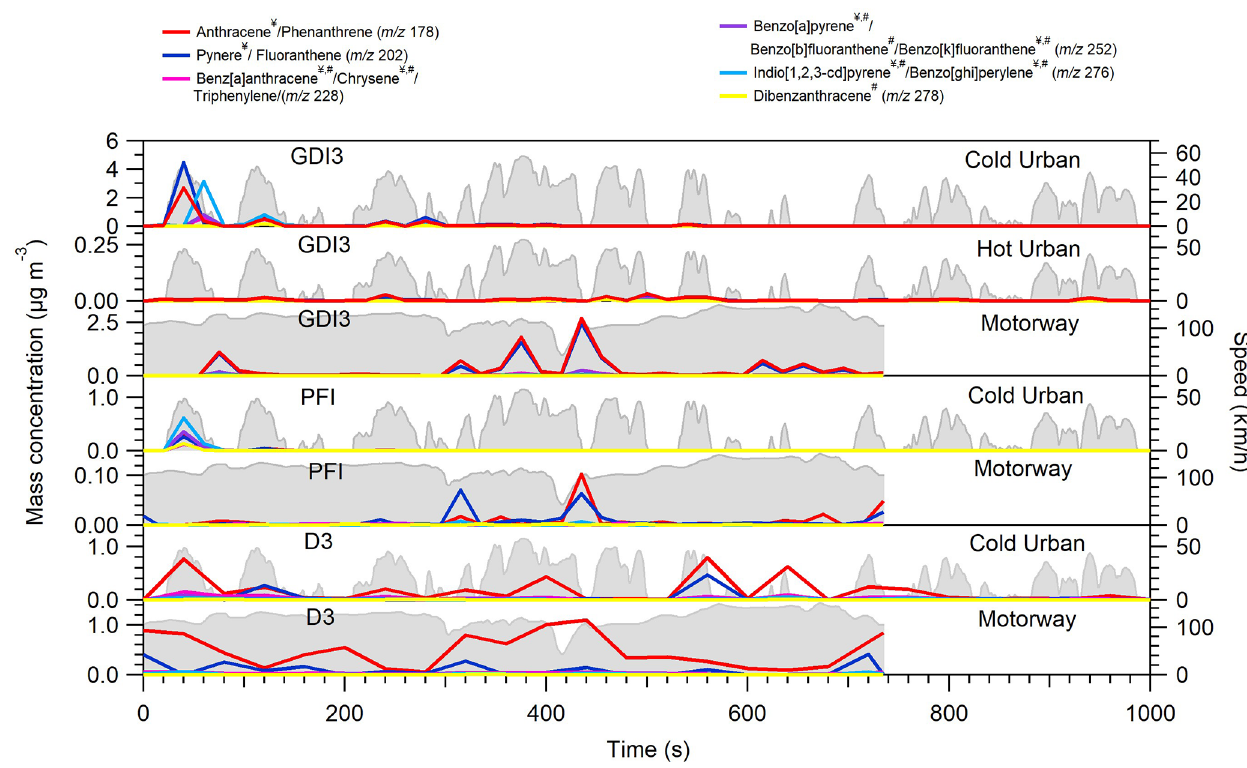
Figure 5. Example of PAH time series profiles for GDI3, PFI, and D3 vehicles for Artemis-tested cycles. The time series have been corrected for the injector dilution (1.5) and for a relative abundance f A ,i = 0.265. Compounds labelled with have been characterized as photomuta- genic, while compounds labelled with # have been found to be cancerogenic (IARC, 2010). The identification and the quantification of their concentration are based on the approach of Herring et al.